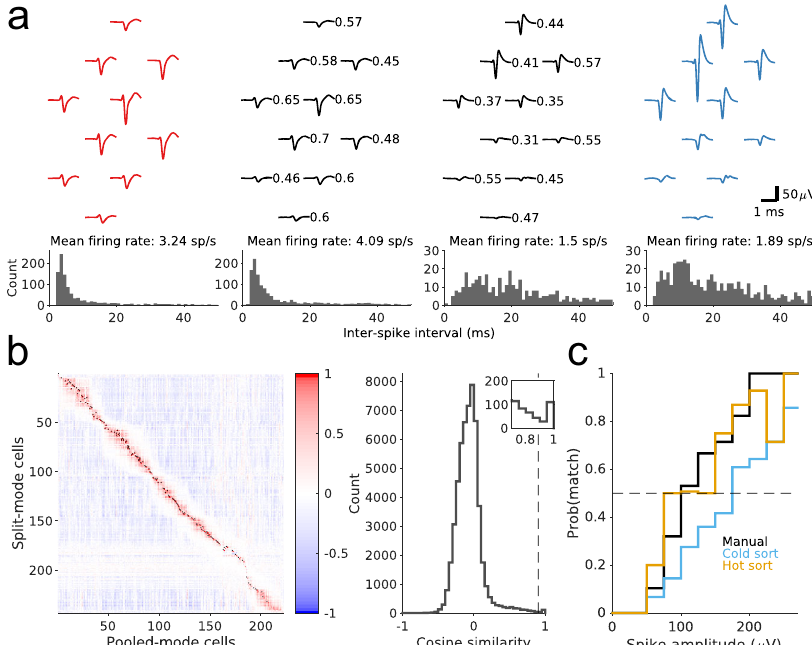
Fig. 5 Recordings from mouse brain. a Matching spike shapes from split- and pooled-mode recordings. Top: Waveforms of two sample units (middle, black) detected in pooled mode on the same set of wires. The left unit was matched to a unit recorded in split mode from Bank 0 (red) and the right unit to one from Bank 1 (blue). Numbers indicate the scaling of the signal of the pooled-mode unit relative to its split-mode signal. Bottom: the mean fi ring rates and the interspike-interval distributions are similar for the matched pairs. b Left: matrix of the cosine similarity between units recorded in pooled- and split- mode, arranged by depth. Black dot indicates greater than the threshold at 0.9. Right: distribution of the cosine similarity. Dashed line indicates the threshold at 0.9. Inset zooms into the 0.7 – 1 range of the distribution. c Fraction of units from the two split recordings that are matched to a unit in the pooled recording as a function of spike amplitude. Three different sorting conditions are shown: sorting all recordings by KiloSort1 followed by manual curation (Manual), sorting all recordings by KiloSort2 (Cold sort), and sorting the pooled recording by KiloSort2 with templates initialized from the split recordings (Hot sort). Dashed line indicates 50%, or the `break-even' point where the pooled-mode yields as many simultaneous recordings as the average